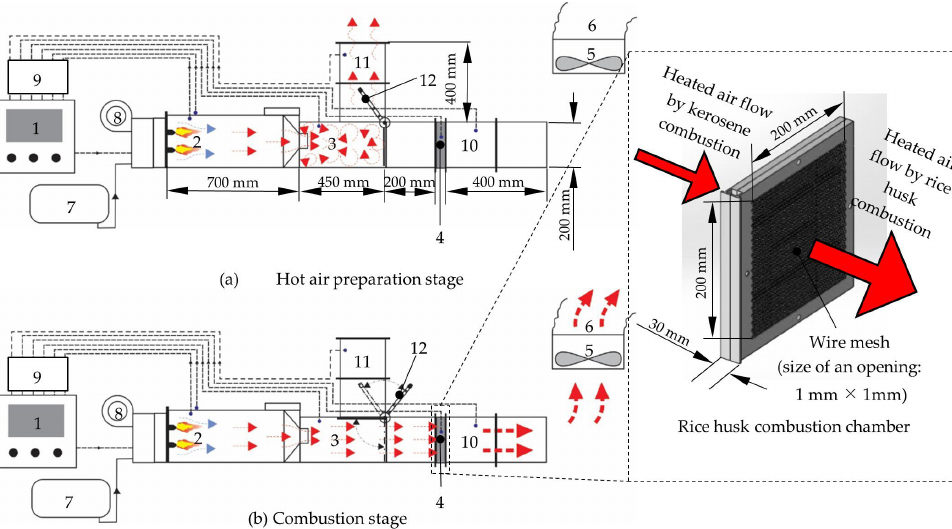
Figure 3. Schematic diagrams of the working principle of the prototype hybrid rice husk burner (PHRB) with a fluidized bed. (1. Displaying and Controlling unit, 2. Kerosene burning unit, 3. Hot air preparation unit, 4. Rice husk combustion chamber, 5. Exhaust fan, 6. Exhaust duct, 7. Kerosene tank, 8. Blower, 9. Temperature sensors, 10. Exhaust outlet for combustion stage, 11. Exhaust outlet for hot air preparation stage, 12. Air releasing lever).